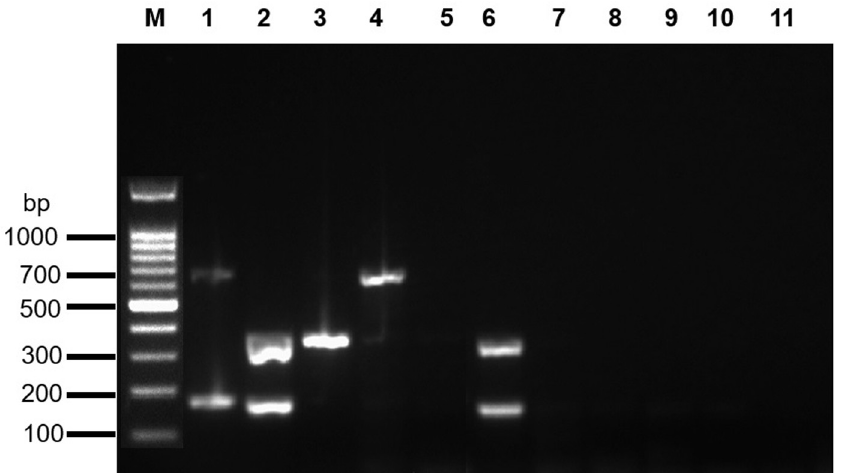
Fig 4. Multiplex RT-PCR applied to VER-IPT samples. Agarose gel electrophoresis of PCR products amplified from RNA extracted from ten VER-IPT samples. Lane M: 100 bp ladder (Invitrogen, Carlsbad, USA); Lane 1–4 and 6: NNV- positive samples; Lane 5 and 7–10: NNV-negative samples; Lane 11: No template control; Molecular weight marker (bp) isindicated to the left of the gel. For sample details see S4 Table.